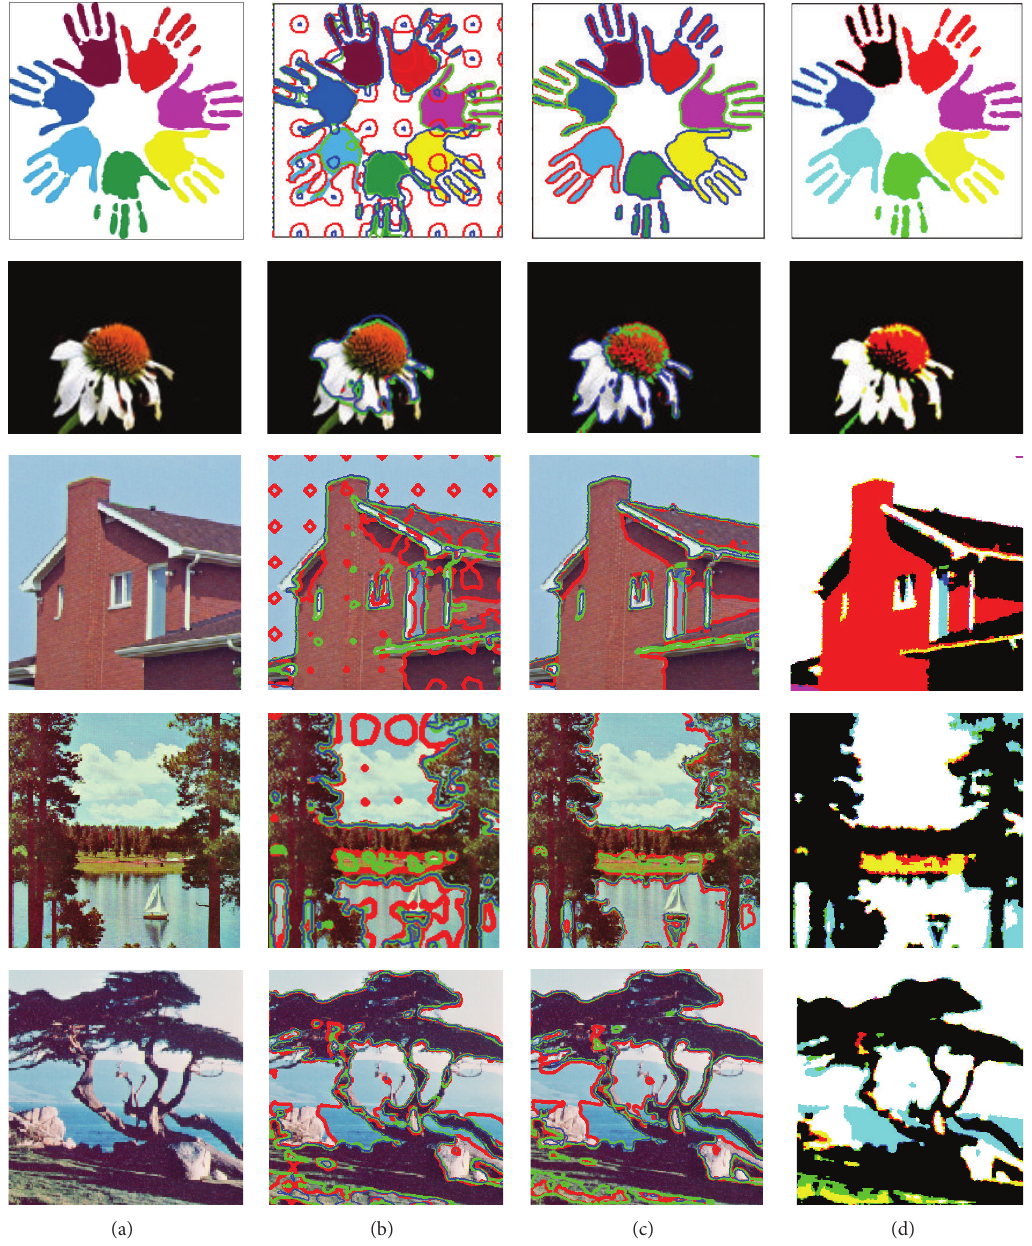
Figure 13: Applications of our model to a group of real images. (a) Original images; (b) intermediate contours; (c) the corresponding final contours; (d) the corresponding segmentation